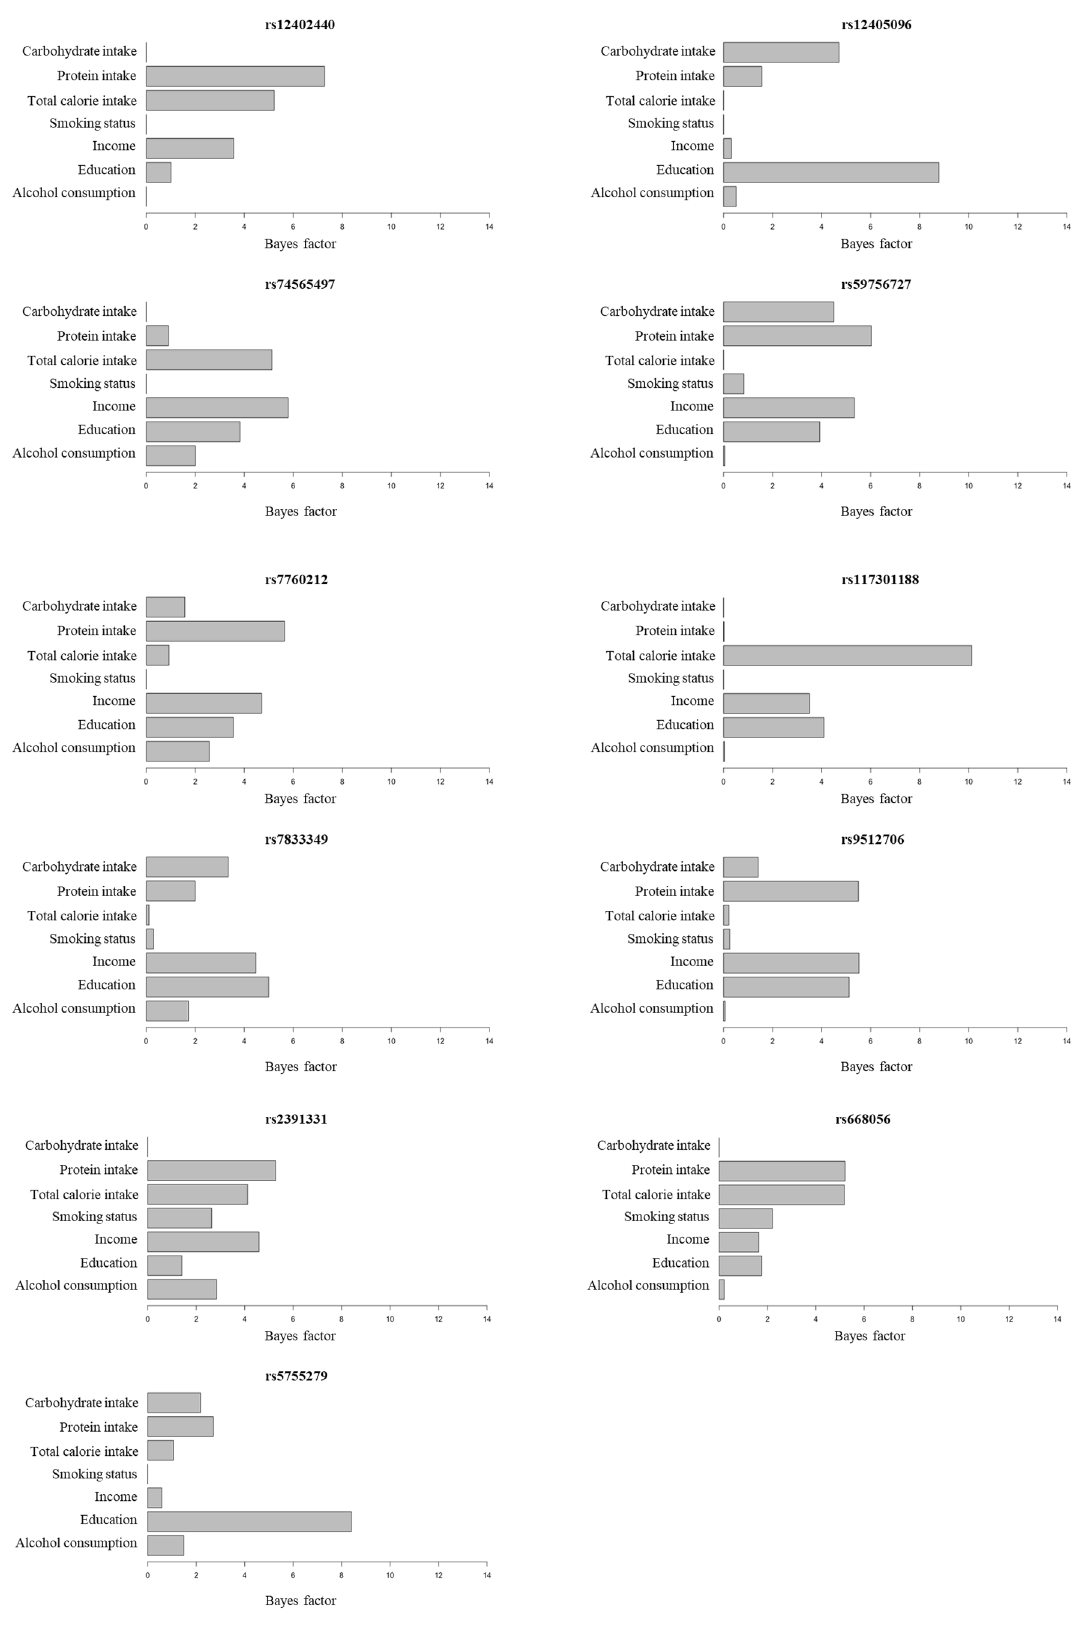
Figure 5. Interaction Bayes factor values of environmental factors for 11 potential single nucleotide polymorphisms (SNPs). Bayes Factor shows evidence of environmental factors that explain GEI at potential